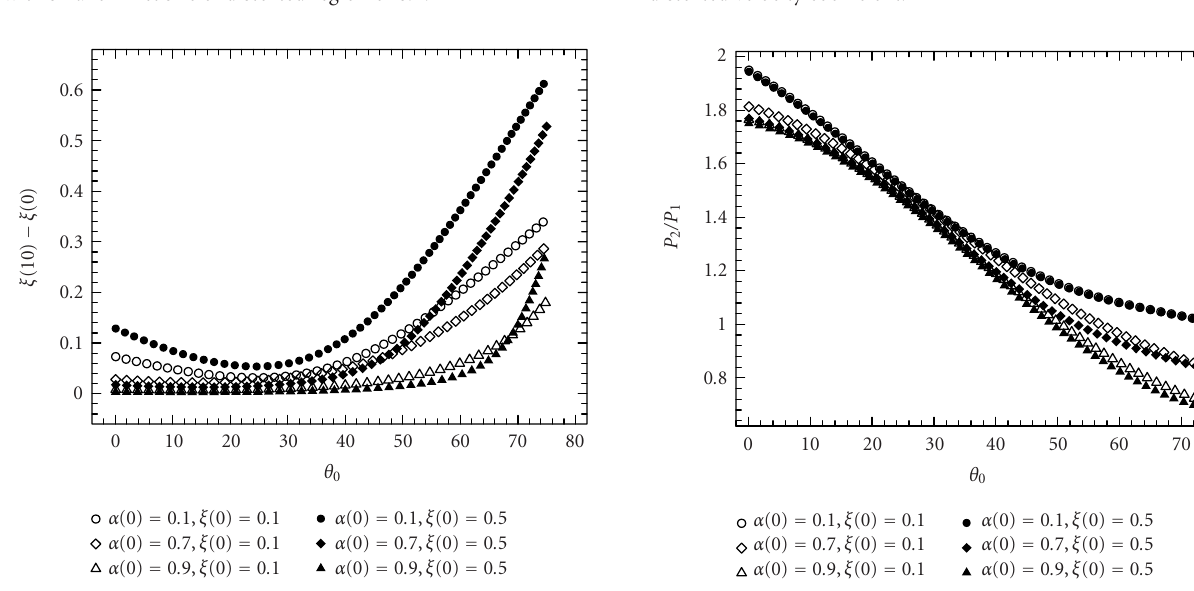
Figure 13: The predicted outlet size of distorted region versus α (0) with smaller inlet size of distorted region of 0 . 1.